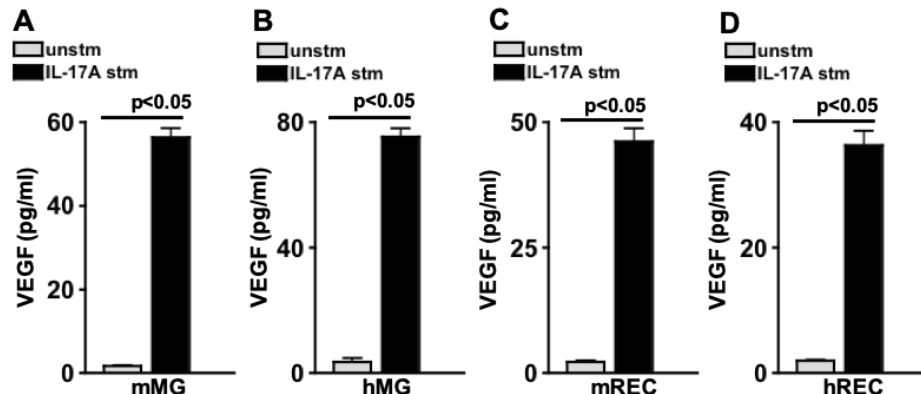
Figure 2. VEGF Production by Retina Cells Stimulated with IL-17A. ELISA quantification of VEGF in spent media of unstimulated (grey) or IL-17A (black) stimulated: ( A ) murine Muller glia (mMG), ( B ) human Muller glia (hMG), ( C ) murine retinal endothelial cells (mREC), and ( D ) human retinal endothelial cells (hREC). Error bars represent the SEM. The p -values were equated by two-way ANOVA and then unpaired Student’s t - test with Tukey’s post -hoc analysis.